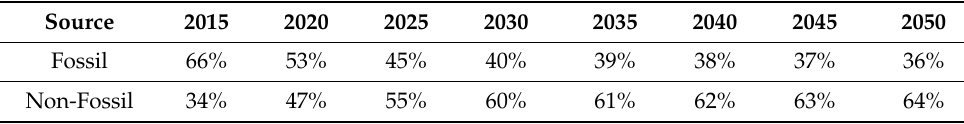
Table 1. The projected share of fossil and non-fossil fuel in power generation in India.